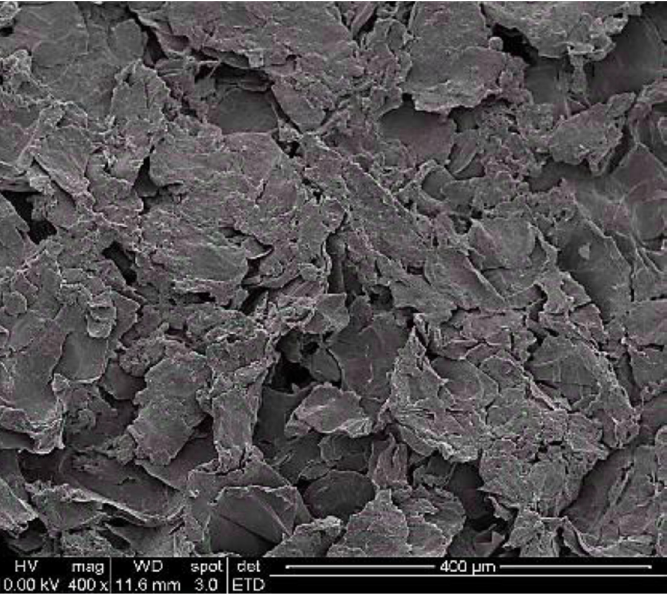
Figure 1. SEM micrograph of GO